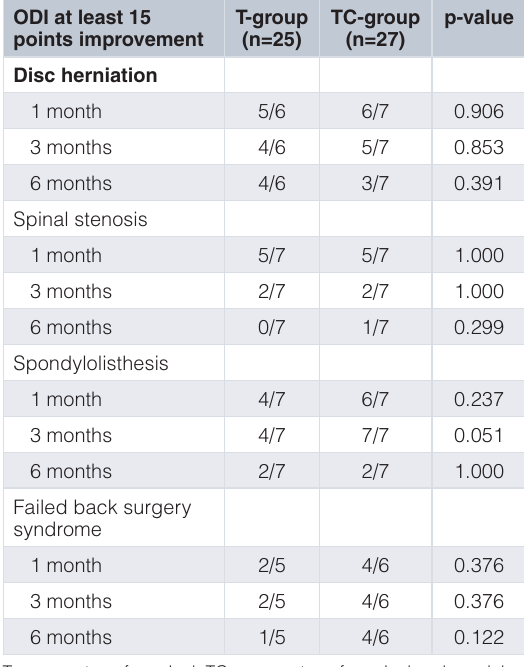
Table 5. The number of patients with improvement of Oswestry Disability Index (ODI) at 15-points or greater at each follow-up period classified by